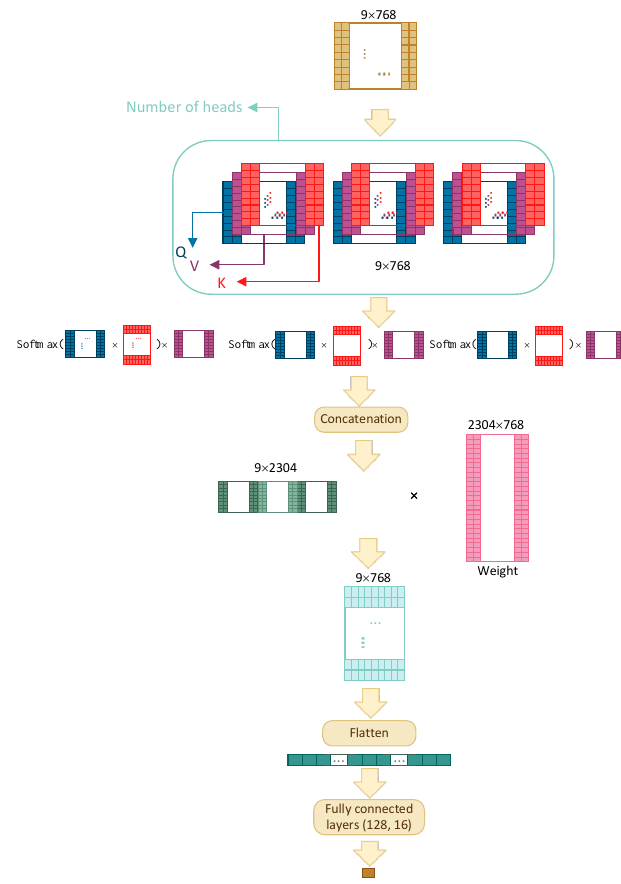
Figure 3. The TF architecture with three attention